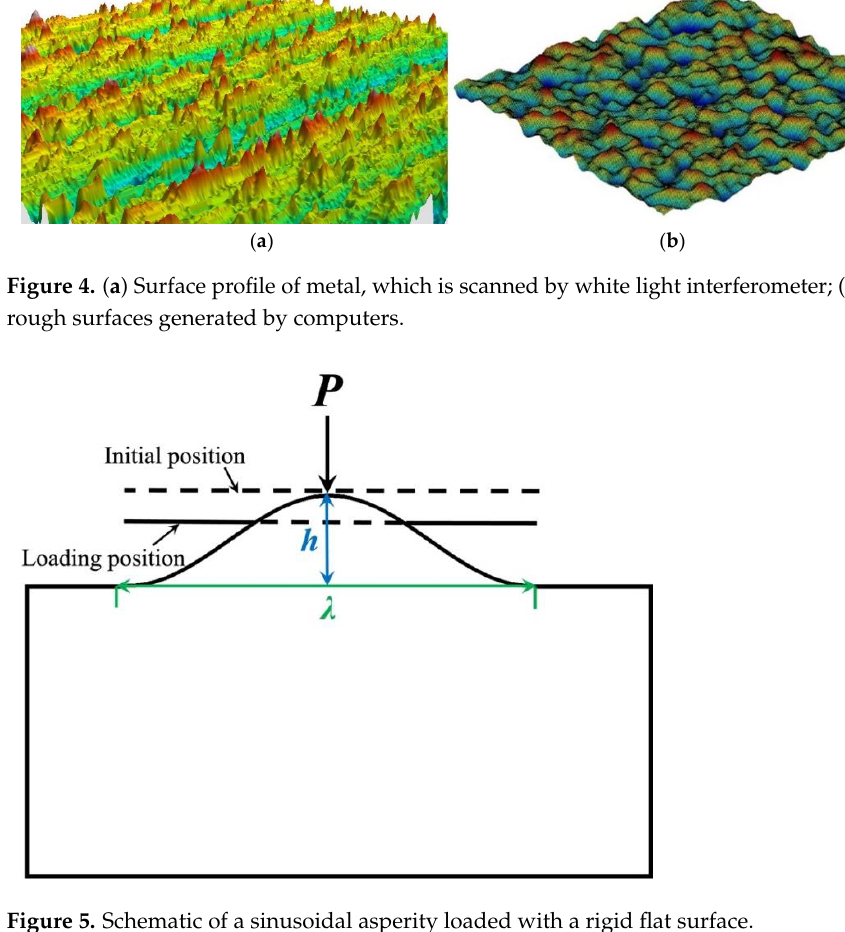
Figure 5. Schematic of a sinusoidal asperity loaded with a rigid flat